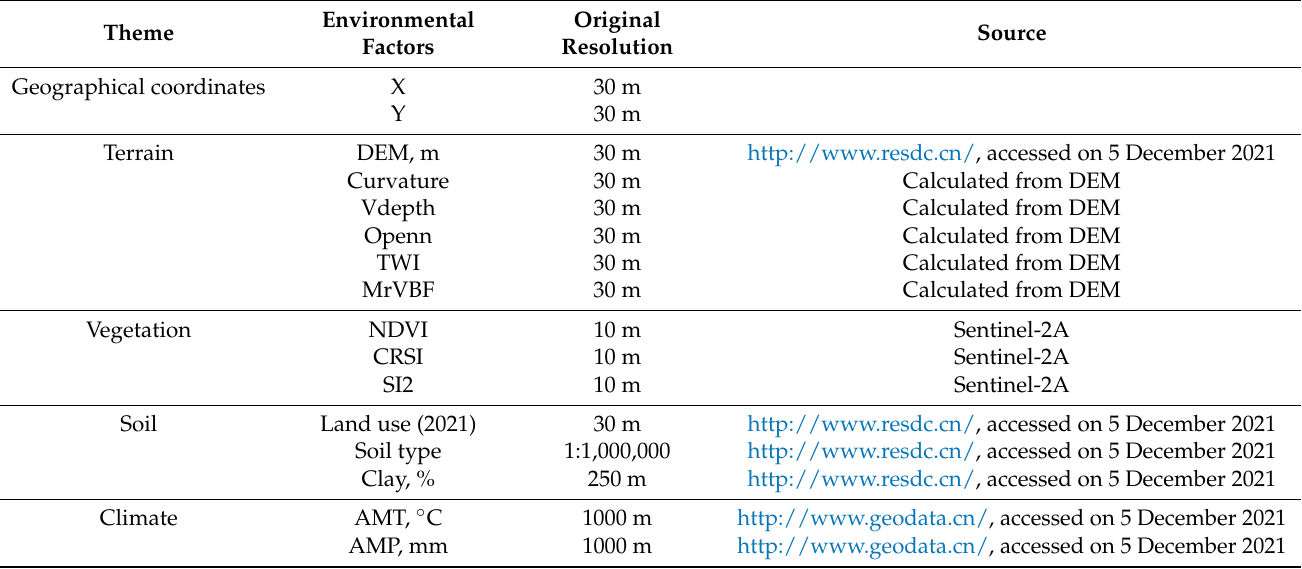
Table 1. Environmental covariates for predicting soil salination and